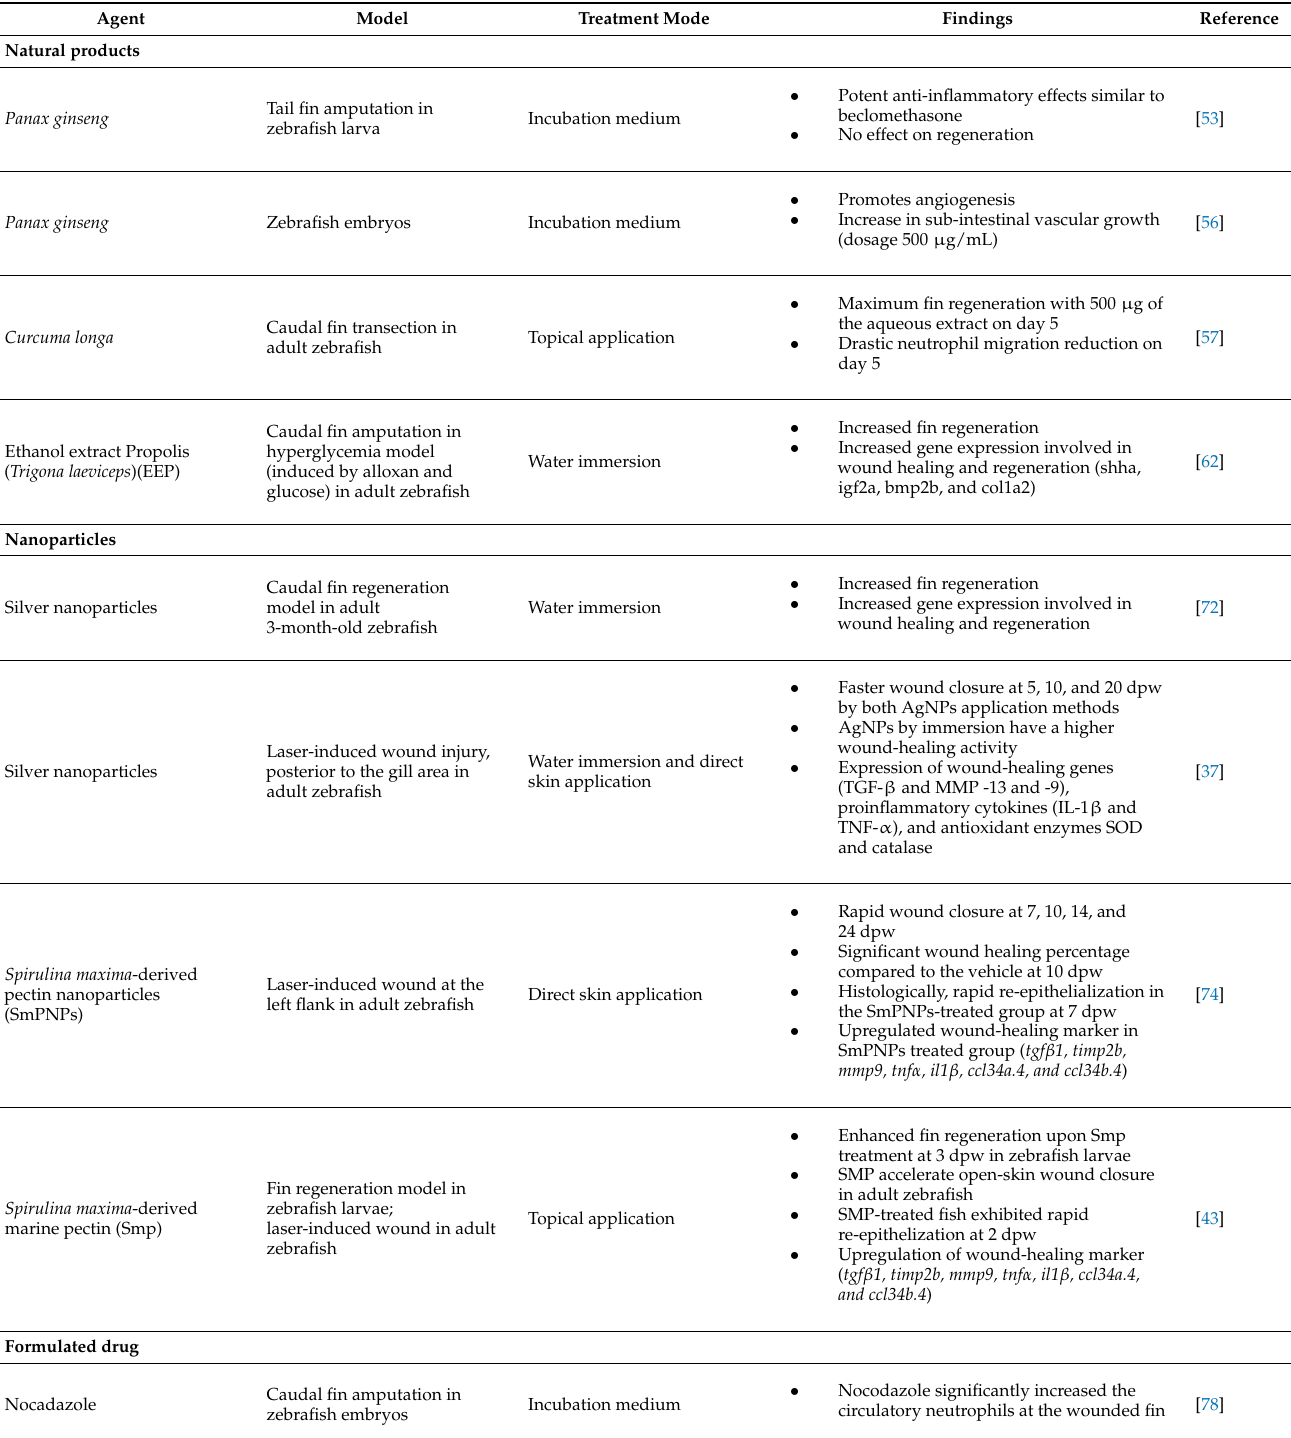
Table 2. Compounds with direct wound-healing effects in zebrafish